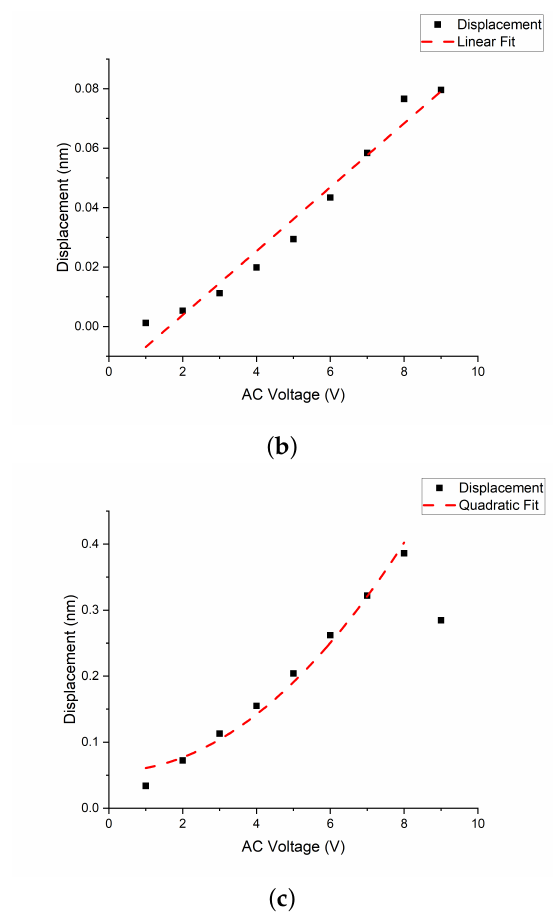
Figure 4. The amplitude of the membrane under ( a ) mechanical actuation (0.1 V AC to 2 V AC and constant 1 V DC) at 163.156 kHz with linear fitting; ( b ) electro-static actuation at 158.640 kHz with signal of the AC voltage changing from 1 V to 9 V and constant 1 V DC, with linear fitting; ( c ) electro-thermal actuation at 156.914 kHz with the voltage of 1–9 V AC and 1 V DC along with parabola